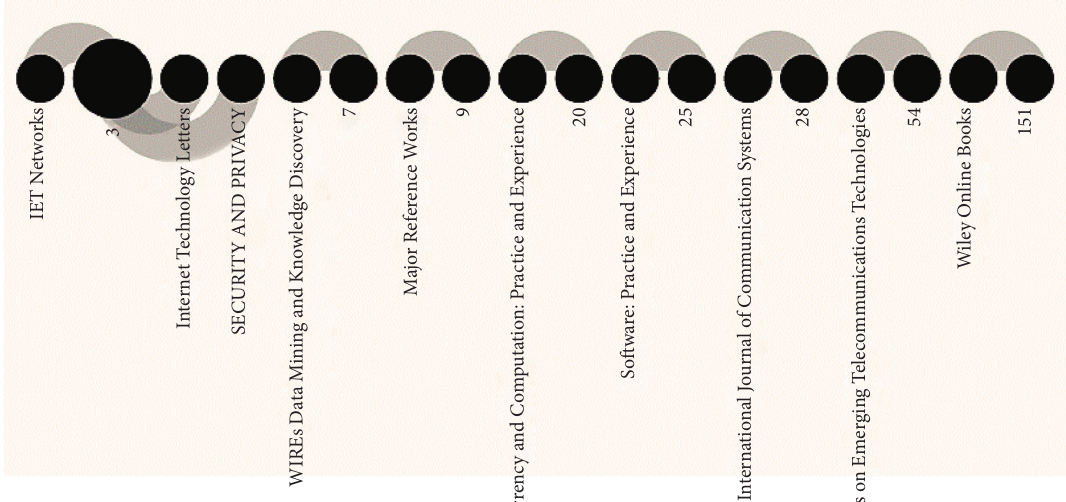
Figure 15: Papers published in the given